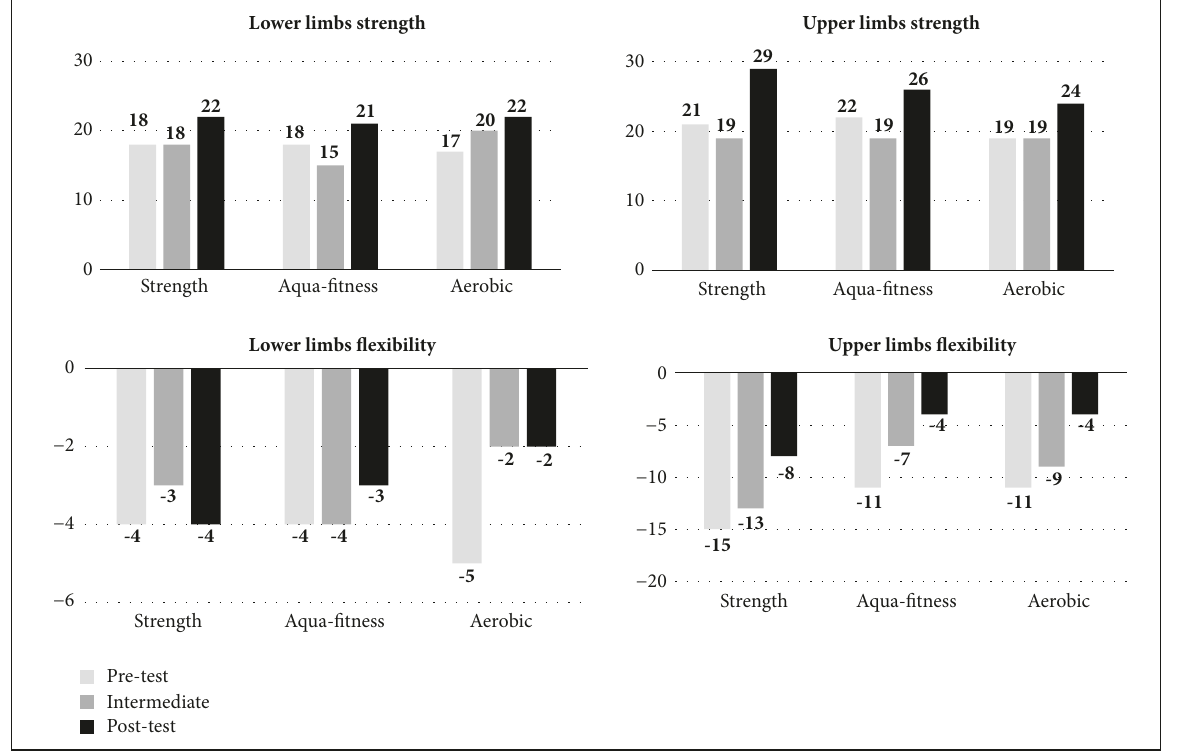
Figure 3: Senior Fitness Test men’s results by activity